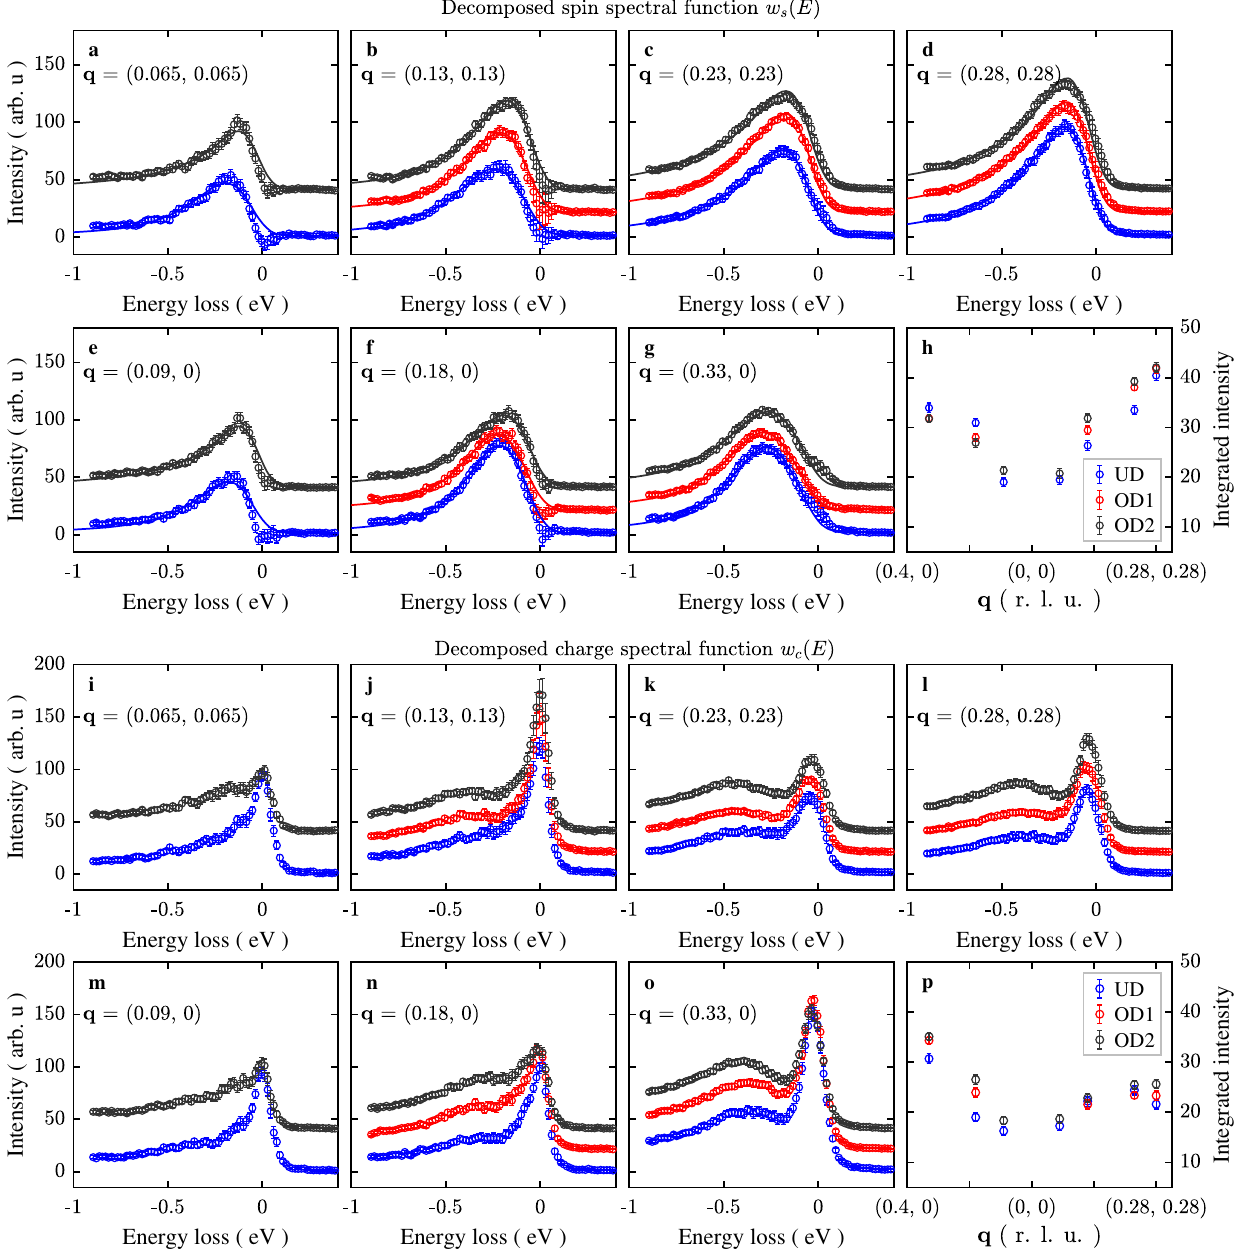
Fig. 3 Momentum and doping dependence of the decomposed spin and charge spectral functions. a – g ( i – o ) display the spin (charge) spectral functions for samples of different doping. The error bars indicate the combined errors of the fi tting, statistic, and errors in determining the zero-energy-loss positions (See Methods). The solid lines in a – g indicate the fi ttings by a damped harmonic oscillator model. h Energy integrated intensities of the spin spectral functions. p Energy integrated intensities of the charge spectral functions with the quasi- elastic peaks subtracted. The error bars in h and p represent the integration errors assuming that the spectral errors have an energy correlation de fi ned by the resolution function (see